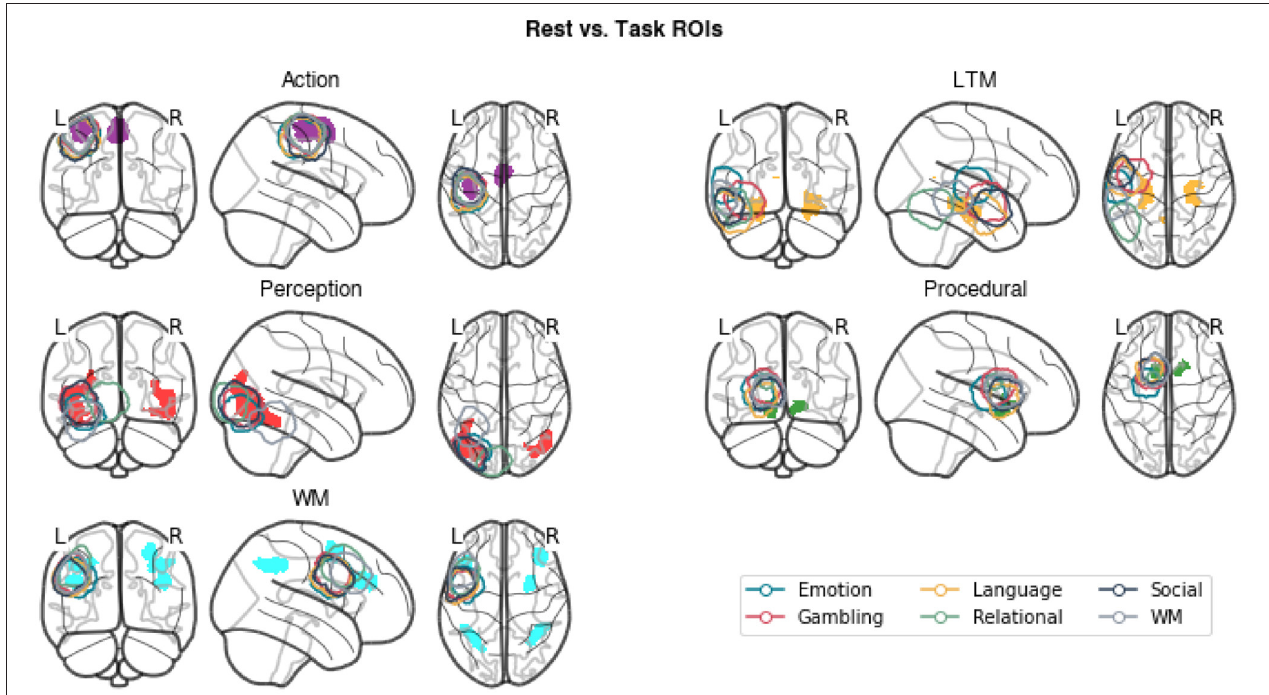
FIGURE 6 | A comparison of the meta-analytic resting-state ROIs (gray) and the group-inclusive task-based ROIs (colored contours) from Stocco et al.